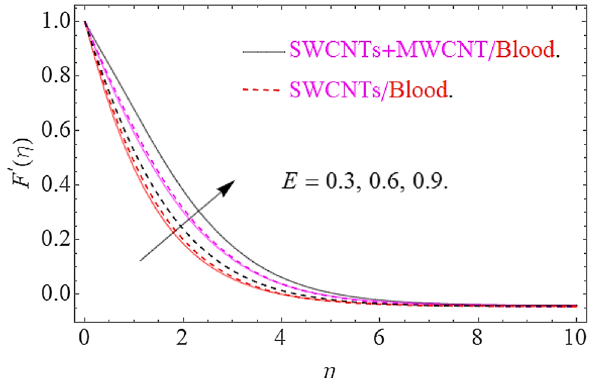
Figure 2. Effects of E on F ′ (η)